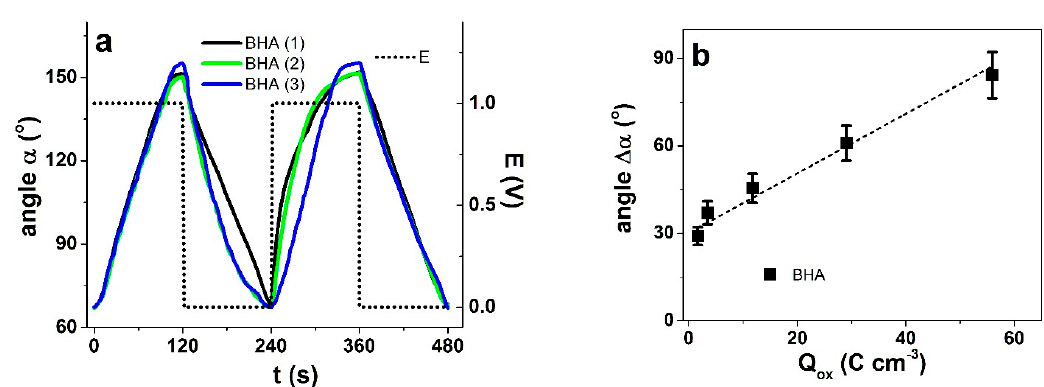
Figure 8. ( a ) Bending displacement of BHA (repeatability shown by three different samples: black, green and blue) in TBACF 3 SO 3 PC as angle α at 4.17 mHz, with potential E (dotted) at 0 V to 1 V showing 2 subsequent cycles and in ( b ) Displacement of BHA ( ■ ) as angle change Δα against charge density upon oxidation Q ox in potential range 0 V to 1 V. The dashed line in ( b ) represents the linear fit, shown here for orientation only.